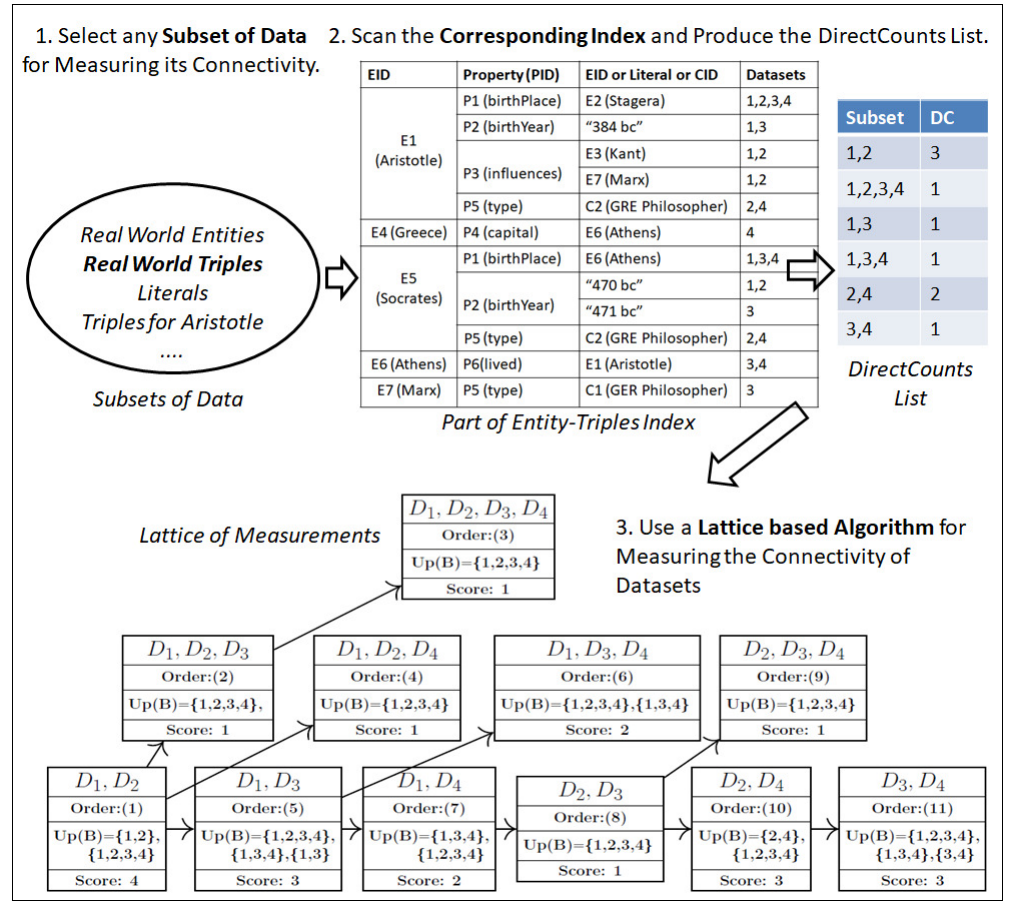
Figure 2. The steps for performing “lattice”-based connectivity